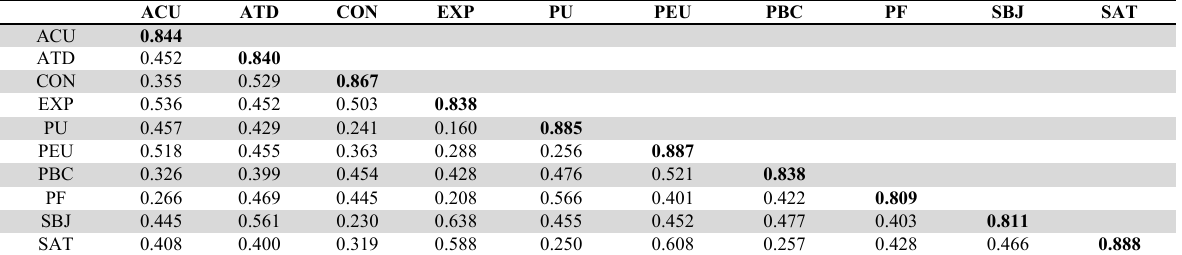
Fornell-Larcker scale